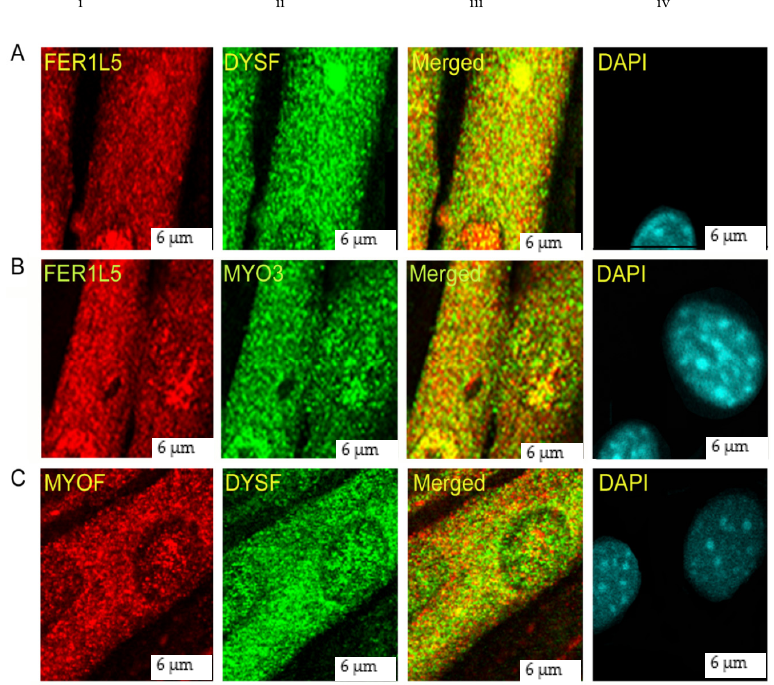
Figure 3. Co-localization studies. Z-series myotube sections are presented. Images showing co- localization studies. ( A ) Fer1L5 (red) channel) and dysferlin (green channel). ( B ) Red, Fer1L5; green, myoferlin. ( C ) Red, myoferlin; green, dysferlin. DAPI stains nucleus (A – C) (blue channel). Yellow colour indicates co-stained regions in the cytoplasm and nucleus ( A – C ), respectively. Scale bar, 6 µm.